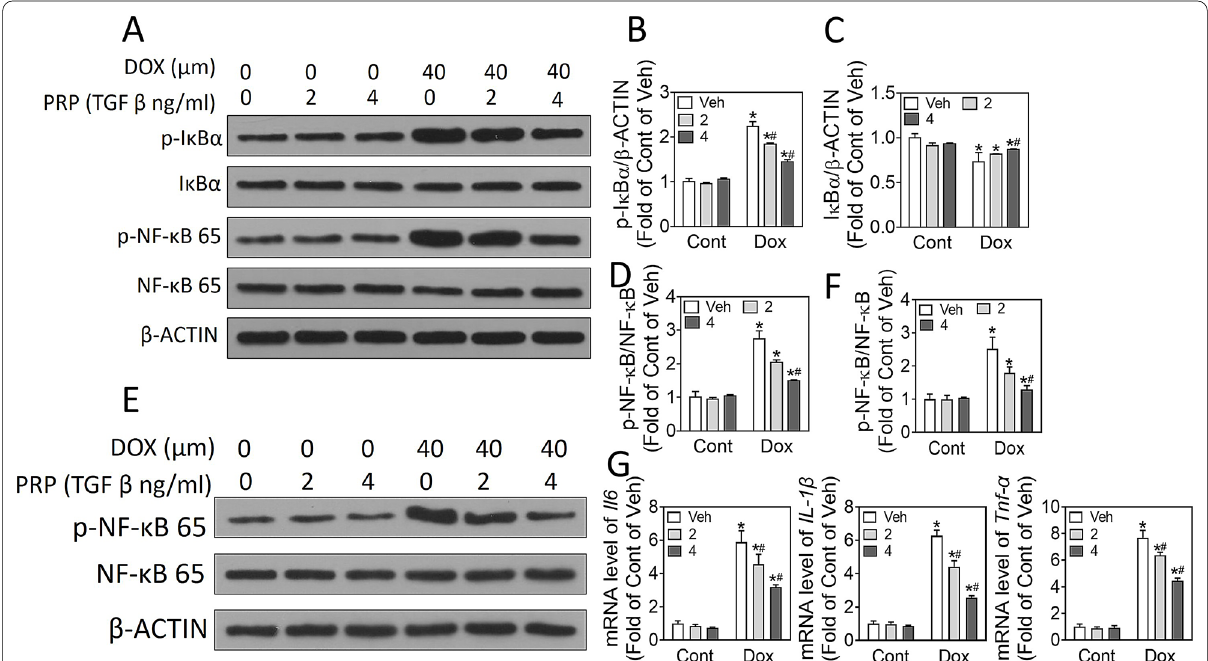
Fig. 4 PRP inhibits doxorubicin-induced inflammation via blocking NF-κB pathway. ATDC5 cells were treated with PRP and doxorubicin for 24 h. A Western blot to exam the protein levels of p-IκBα, IκBα, p-NF-κB 65, NF-κB 65, and β-ACTIN. B – D Quantitation of the immunoblots. At least three independent experiments were performed. E BMM cells were treated with PRP and doxorubicin for 24 h. Western blot results of the protein levels of p-NF-κB, NF-κB, and β-actin. F Quantitation of the immunoblots. G Real-time PCR to detect mRNA levels of IL-6, IL-1β, and TNF-α. *p < 0.05 vs control of the same doxorubicin treatment; # p < 0.05 vs vehicle of the same TGF β